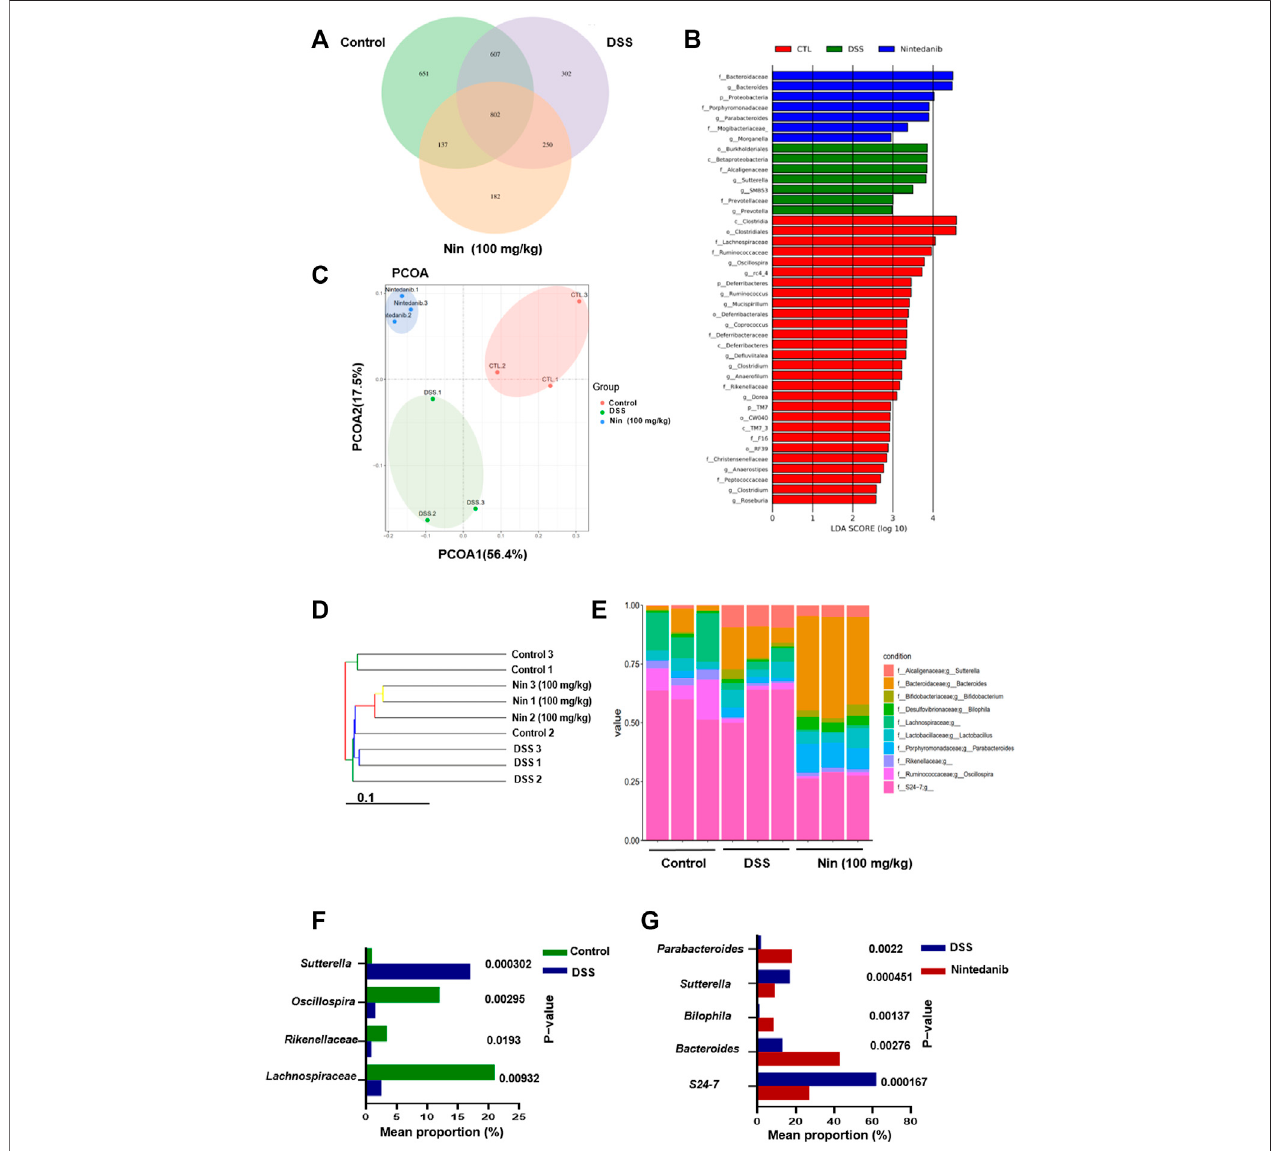
FIGURE6| NintedanibregulatesthegutmicrobiotacompositionofDSS-inducedexperimentalcolitis. (A) TheVenndiagramshowingtheuniqueandsharedOTUs from control, DSS, and nintedanib groups. (B) The difference of OTUs among the control group, the DSS group, and the nintedanib group was determined by linear discriminantanalysiscombinedwitheffectsize(lefse). (C) PCOAofgutmicrobiotacommunitiesbasedontheOTUlevel. (D) Theclusteringanalysisoftheevolutionofthe gut microbiotas between control, DSS, and nintedanib groups. Based on the distance matrix, the gut microbiota tree was constructed using the UPGMA (unweightedpairgroupmethodwitharithmeticmean)clusteringmethodforanalysis. (E) Histogramsofrelativeabundanceofgroupedspeciesatthegenuslevel. (F) Gut microbiota differentially expressed at genus level between control and DSS groups. (G) Gut microbiota differentially expressed at genus level between DSS and nintedanib